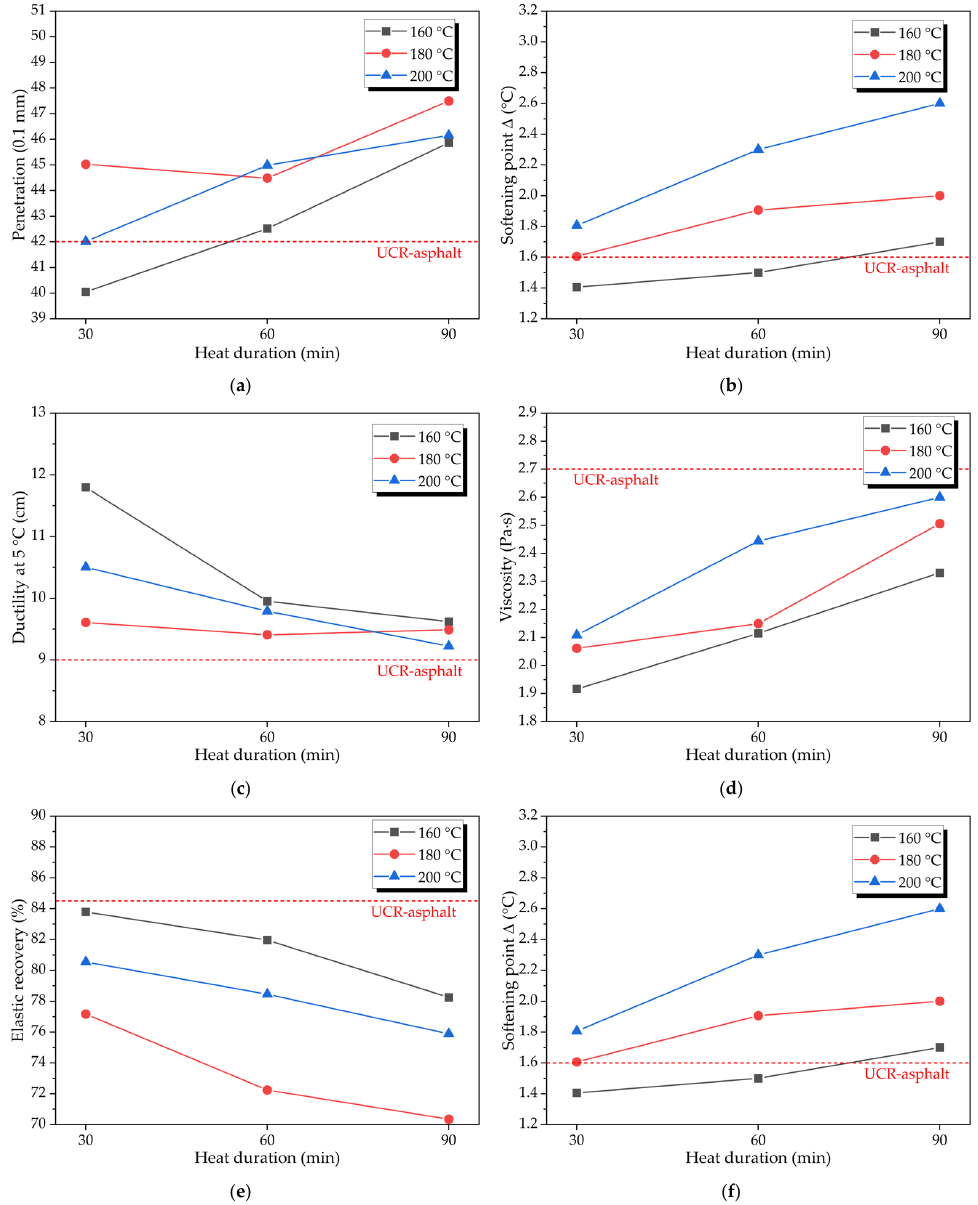
Figure 11. The conventional physical properties of asphalt binder containing activated crumb rubber powder prepared by the heat treatment method: ( a ) penetration; ( b ) softening point; ( c ) ductility at 5 °C; ( d ) viscosity; ( e ) elastic recovery; and ( f ) softening point Δ .